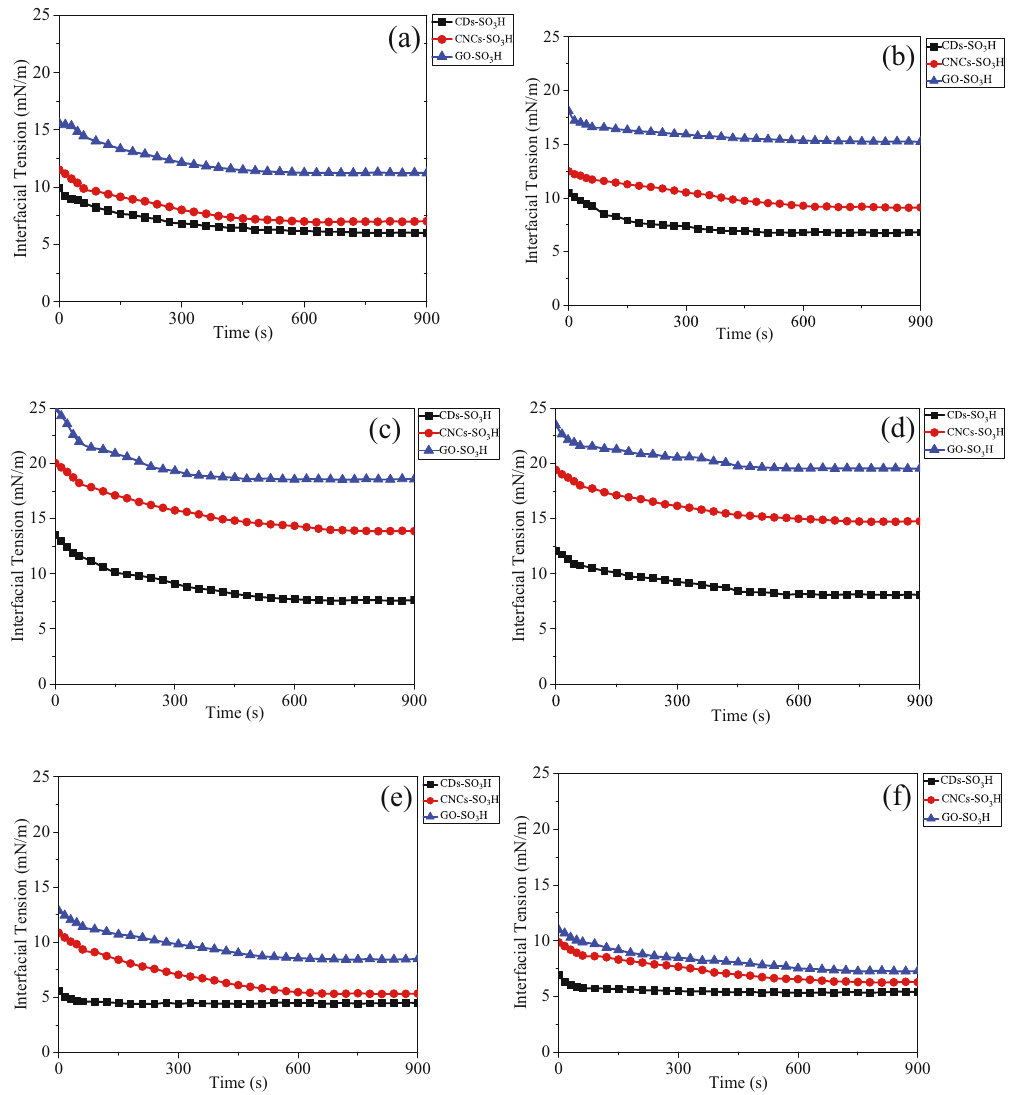
Figure 6: NPs ( 10 mg/mL ) compounding with aminated PS ( 1 mg/mL ) at pH = 3. ( a ) PS – NH 2 ( M n ≈ 0.5k ) ; ( b ) PS – NH 2 ( M n ≈ 2.1k ) ; ( c ) PS – NH 2 ( M ≈ 2.9k ) ; ( d ) PS – NH n